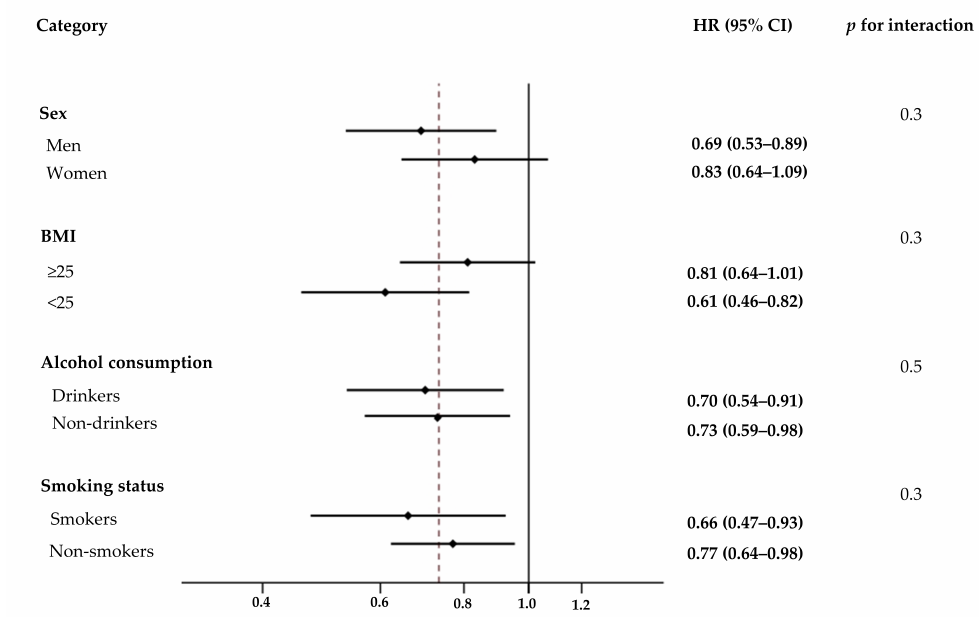
Figure 2. Effect of various demographic factors on the association between yogurt intake and risk of type 2 diabetes mellitus (T2DM). Hazard ratios (HRs) and 95% confidence intervals (CIs, shown